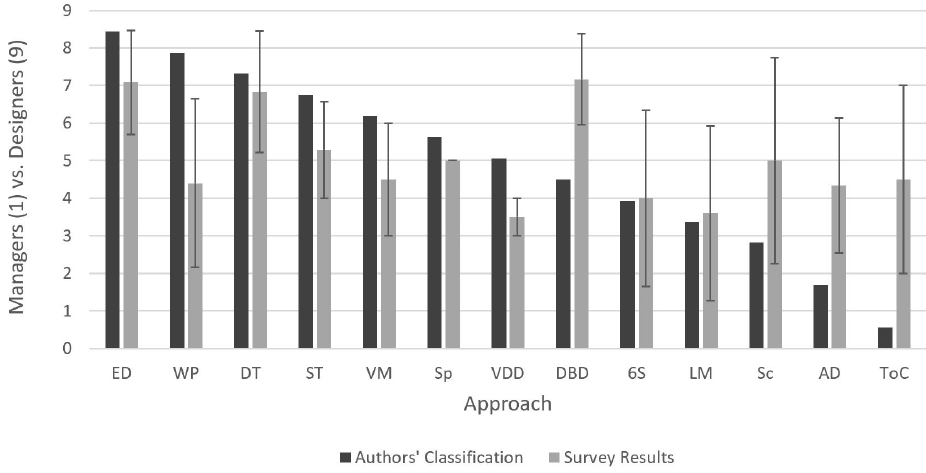
Figure 10. Focus of approach on managers vs. designers, based on survey responses and authors’ classifications. Error bars on survey results represent standard deviations above and below the average response value. Approaches are ordered by decreasing authors’ initial ranks.